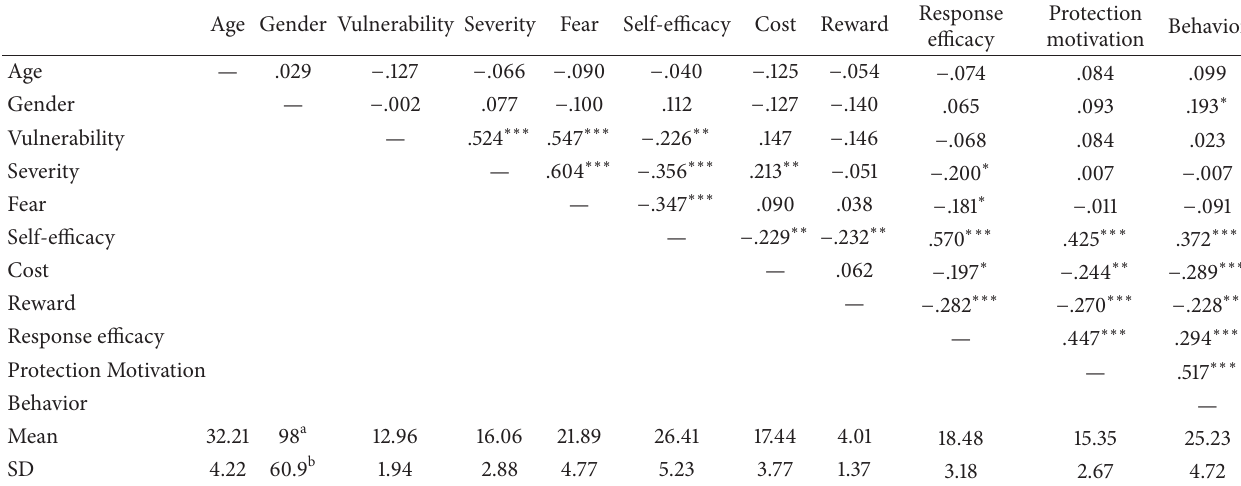
Table 4: Descriptive statistics and intercorrelations between the main measures ( 𝑁 = 162